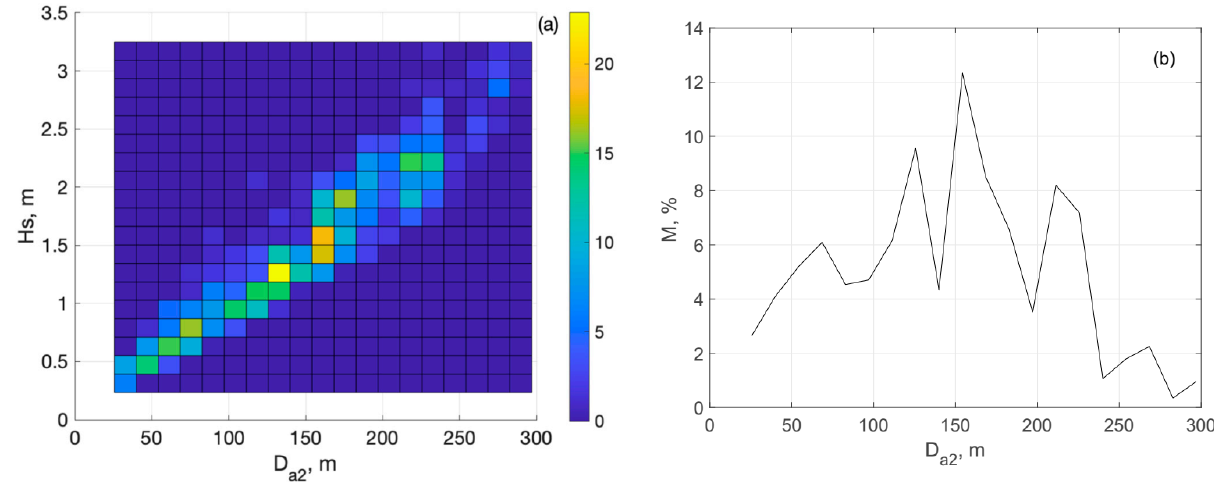
Figure 10. ( a ) Bivariate histogram depending on the value of the second harmonic maximum distance off the shoreline weighted by the dimensionless relation between the significant wave height and depth of the second harmonic maximum; ( b ) wave impact metric (Equation (6)) dependent on the distance from the second harmonic maximum to the